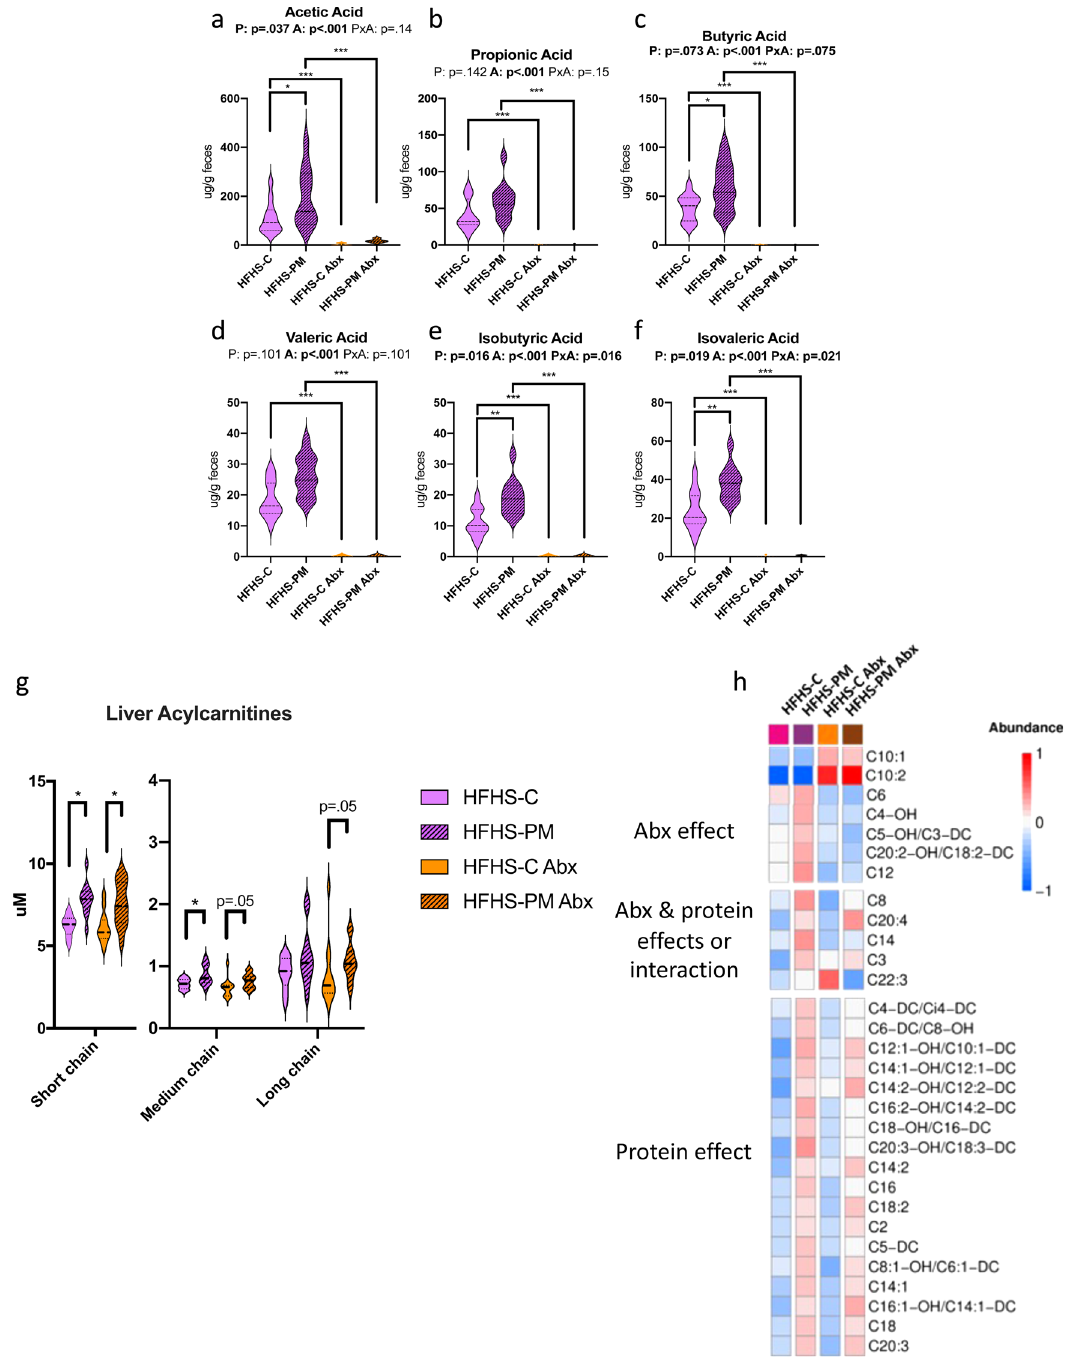
Fig. 6 Antibiotics (Abx) prevent SCFA and BCFA production while mitigating diet impact on hepatic acylcarnitines. Mice were fed with a HFHS-C (purple) or a HFHS-PM (purple, hatched) and administered with an antibiotic cocktail (orange, and orange, hatched, respectively). Fecal levels of major SCFA ( a ) acetic, ( b ) propionic, and ( c ) butyric acid, and minor SCFA ( d ) valeric, ( e ) isobutyric, and ( f ) isovaleric acid after 2 weeks of dietary intervention. Hepatic ( g ) acylcarnitine pro fi le and speci fi c ( h ) acylcarnitine changes attributed to antibiotic treatment, protein source, or both. Short- chain AC: C2 to C4; Medium-chain AC: C5 to C10; Long-chain AC: C12 to C22. Data are represented as median, interquartile range, minimum and maximum. Metabolite concentrations were log10 transformed and Pareto scaled before generating a heatmap. Statistical analyses were performed using a two-way ANOVA followed by a Tukey post-hoc test. n = 12 biologically independent mice for all groups. P -values of general effect for protein (P) and antibiotic (A) factors and protein × antibiotic (P × A) interaction are recorded under the title of each graph. Detailed signi fi cant differences detected by post-hoc test are recorded as follows: * p < 0.05, ** p < 0.01, *** p < 0.001. Exact p -values for trends (0.05 ≤ p -value < 0.10) are recorded on graphs for an additional indication. See also Supplementary Figs. 7 and